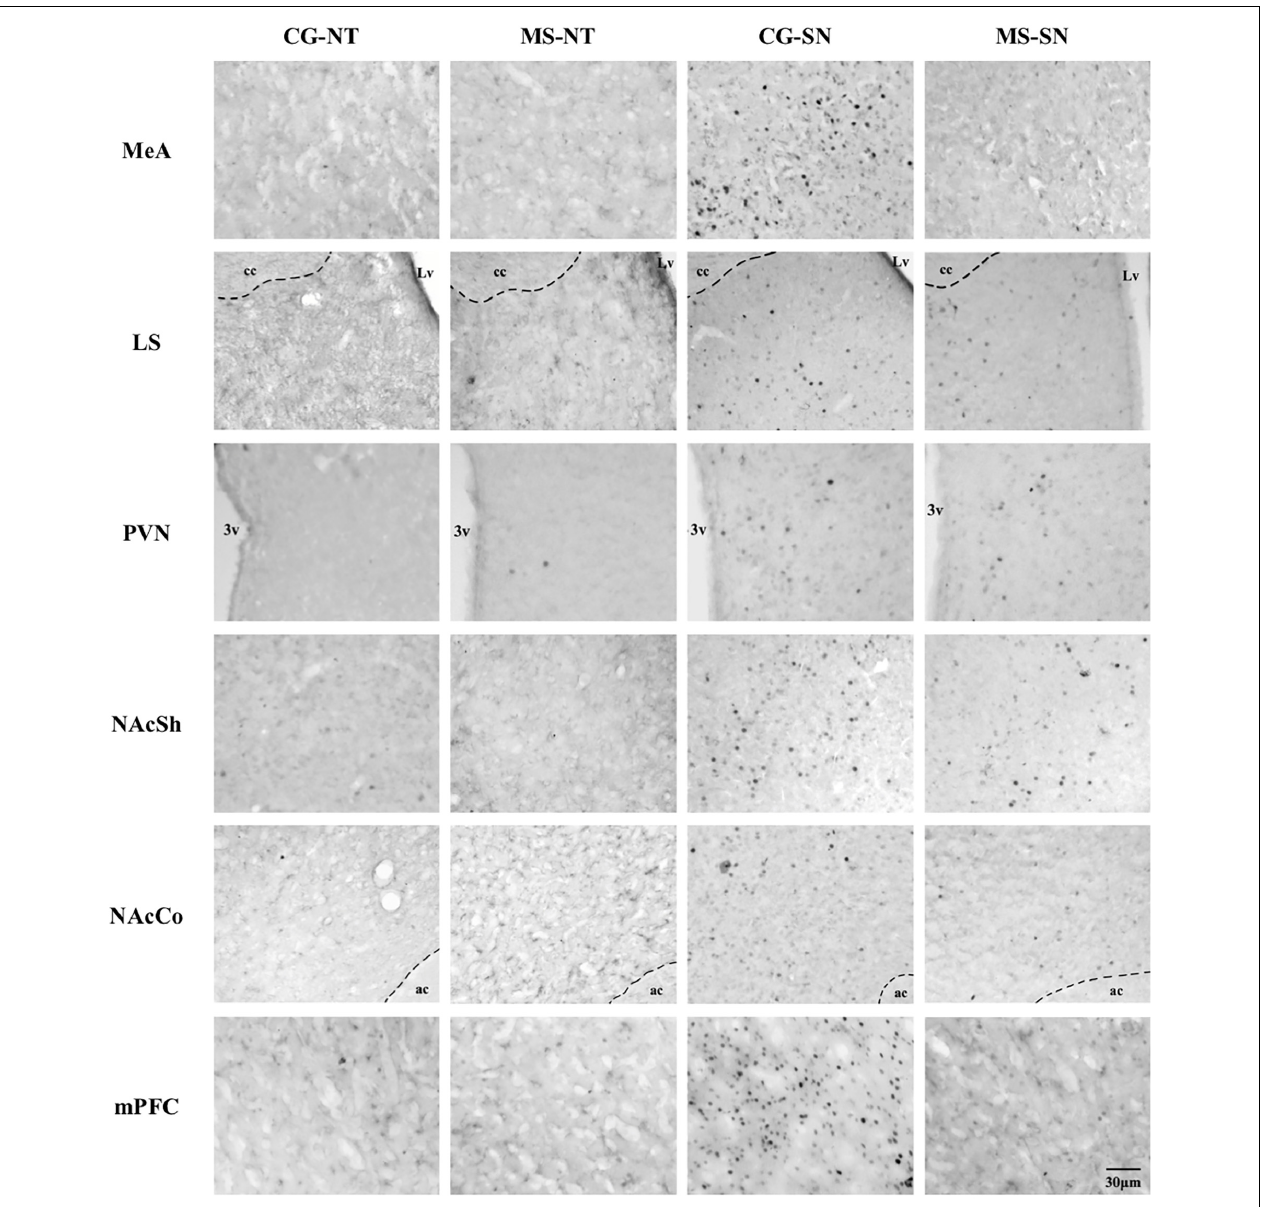
FIGURE 5 | Microphotographs of the analyzed brain sections for c-Fos positive cells. Columns represent the experimental groups (CS-NT, MS-NT, CS-SN, and MS-SN); rows represent the brain areas (MeA, LS, PVN, NAcSh, NAcCo, and mPFC). The scale bar represents 30 µ m for all photographs. CS-NT, Control Subjects-No Test group; MS-NT, Maternal Separation-No Test group; CS-SN, Control Subjects-Social Novelty Group; MS-SN, Maternal Separation-Social Novelty group; MeA, Medial Amygdala; LS, Lateral Septum; PVN, paraventricular nucleus; NAc, Nucleus Accumbens, NAcSh, Nucleus Accumbens Shell; NAcCo, Nucleus Accumbens Core; mPFC, medial Prefrontal Cortex; 3v, third ventricle; Lv, lateral ventricle; cc, corpus callosum; ac, anterior